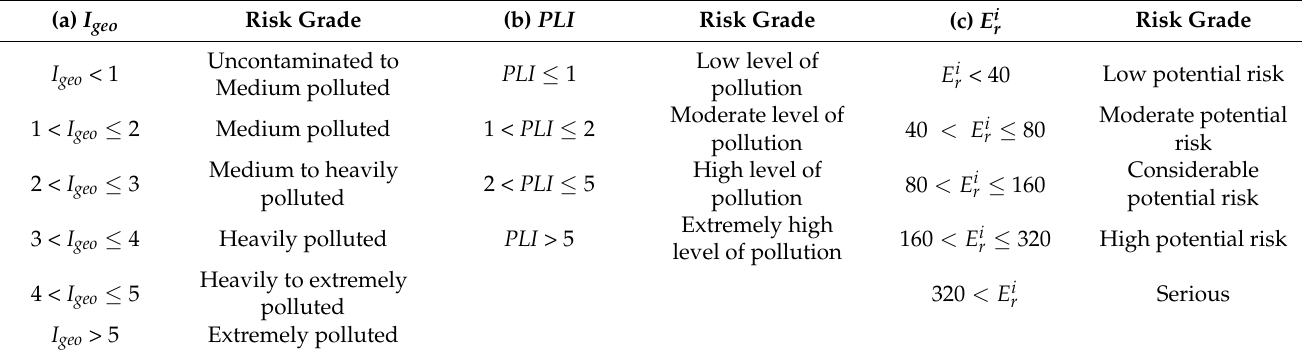
Table 1. (a) I geo value and assessment standards; (b) Potential ecological risk index and assessment standards; (c) Ecological risk factor and assessment